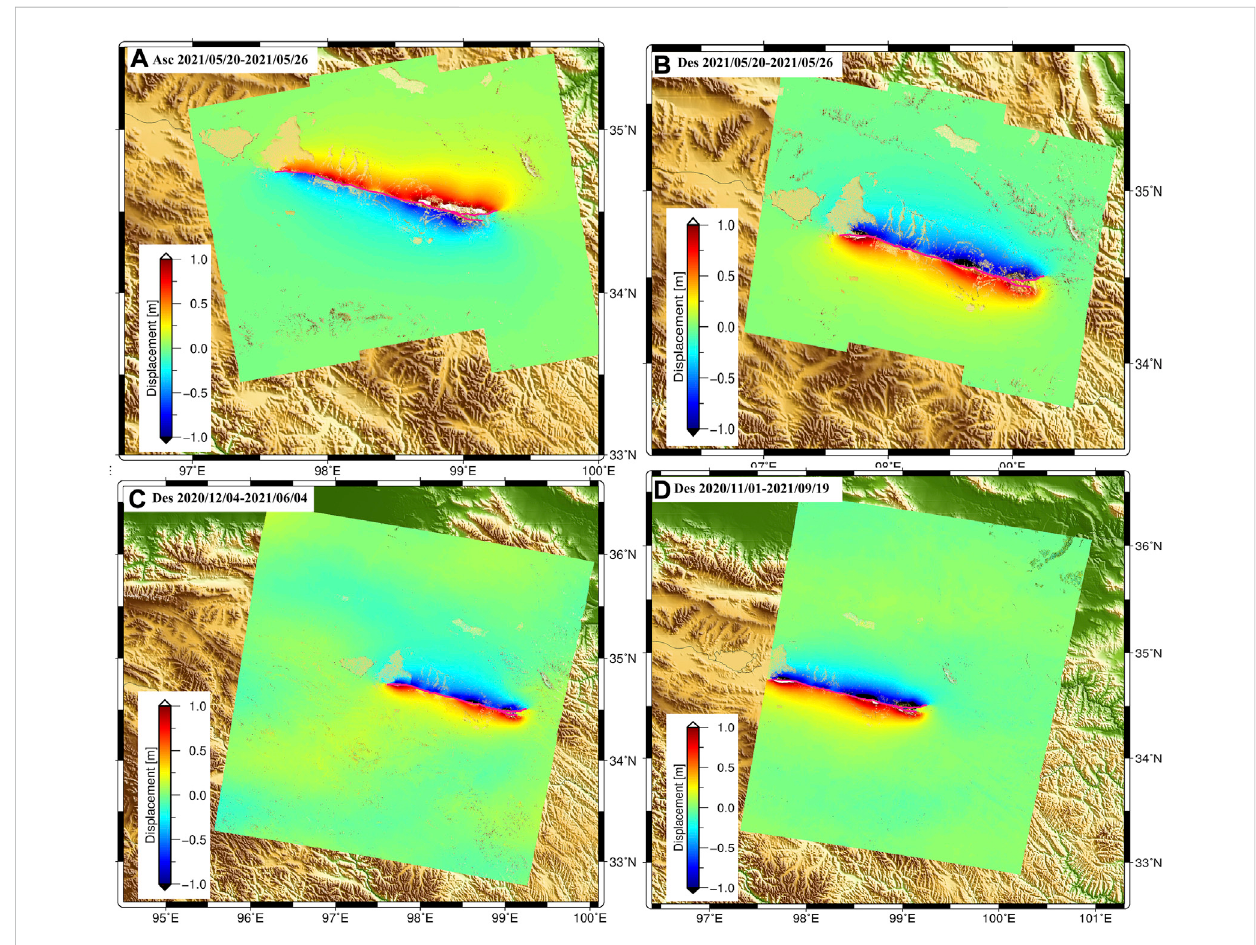
FIGURE 2 Satellite LOS displacement fi elds derived fromascending (A) and descending (B) of S1data as wellas track 41 (C) and track 42 (D) ofALOS-2 satellite in descending